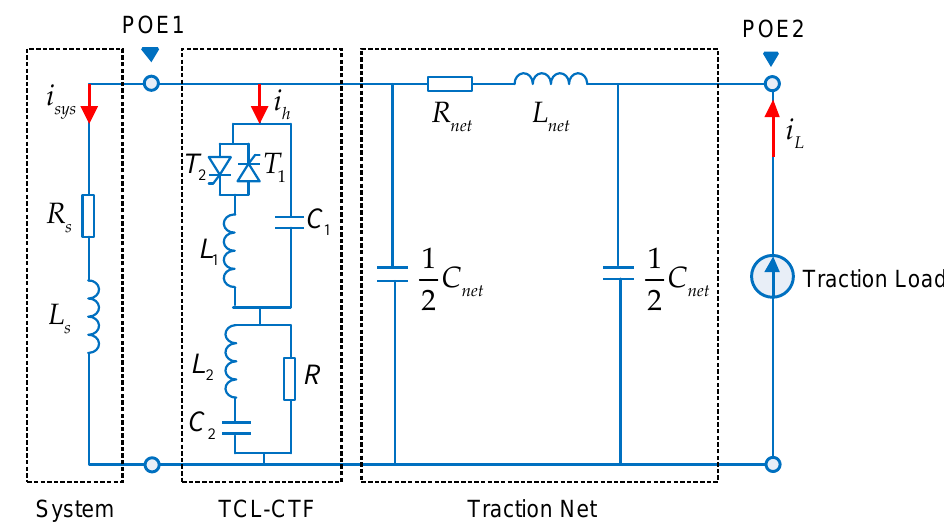
Figure 4. Resonance Damping Analysis. ( a ) Impedance-frequency response determined by different L 1 ; ( b ) Impedance-frequency response determined by different R; ( c ) Impedance-frequency response determined by different C 1 .